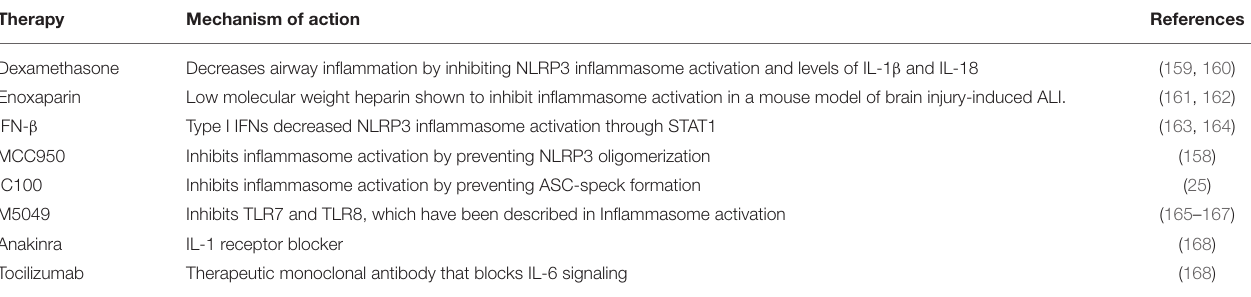
TABLE 3 | Potential therapies targeting the inflammasome that could be used in the care of COVID-19 patients. Therapy Mechanism of